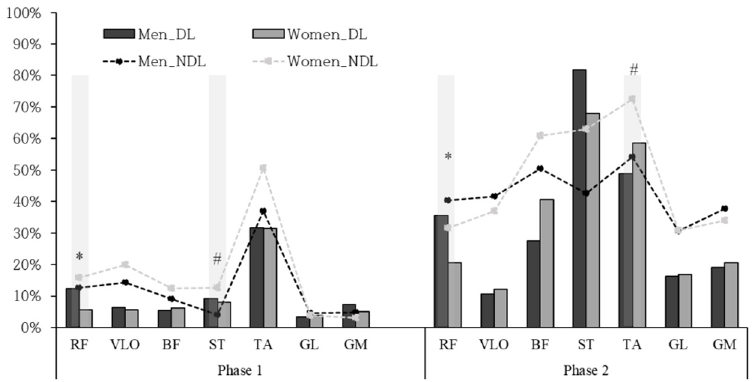
Figure 3. Average muscle activation of dominant and non-dominant leg in fencing national athletes. DL, dominant leg; NDL, non-dominant leg; *, the difference between the male and female athletes in the dominant leg ( p < 0.05); #, the difference between the male and female athletes in the non-dominant leg ( p < 0.05).